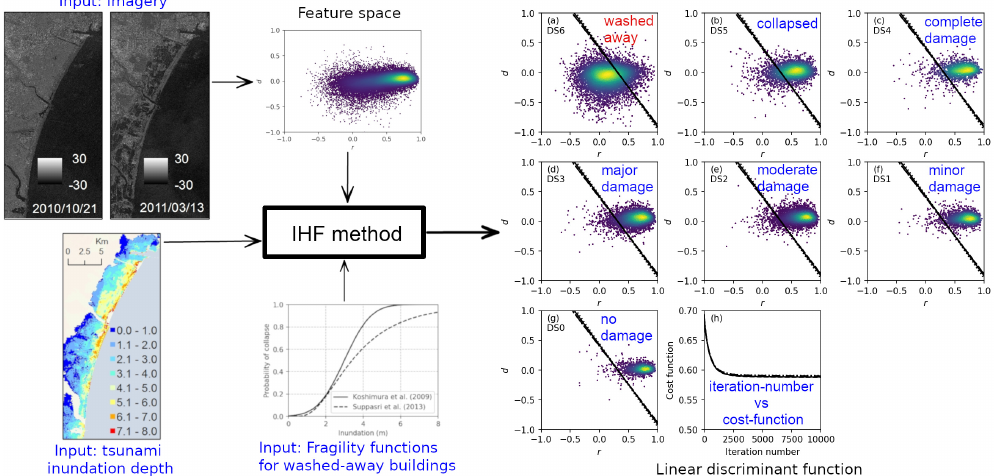
Figure 11. Scheme of the Imagery, Hazard, and Fragility Function (IHF) method applied to the 2011 Tohoku tsunami. TerraSAR-X data is used to construct the feature space, where each sample represents a building. Then each building is associated with a probability of of damage according to the inundation depth map and fragility functions. Finally, a discriminant function is calibrated from Equation (6). The example shows the resulting linear discriminant function that separates washed away buildings from the rest. The figure is modified from